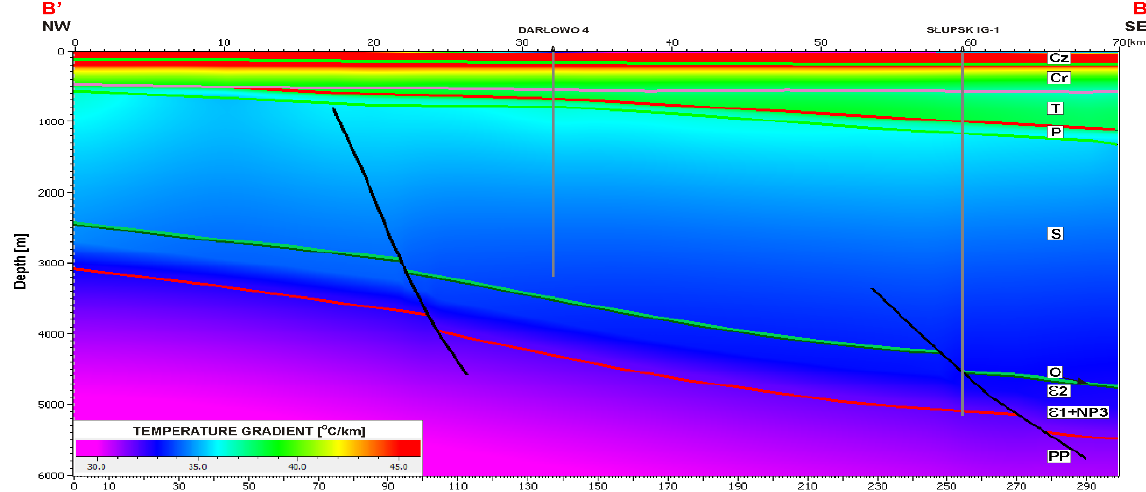
Figure 11. Recent average vertical temperature gradient showing the decreasing trend with the burial depth.